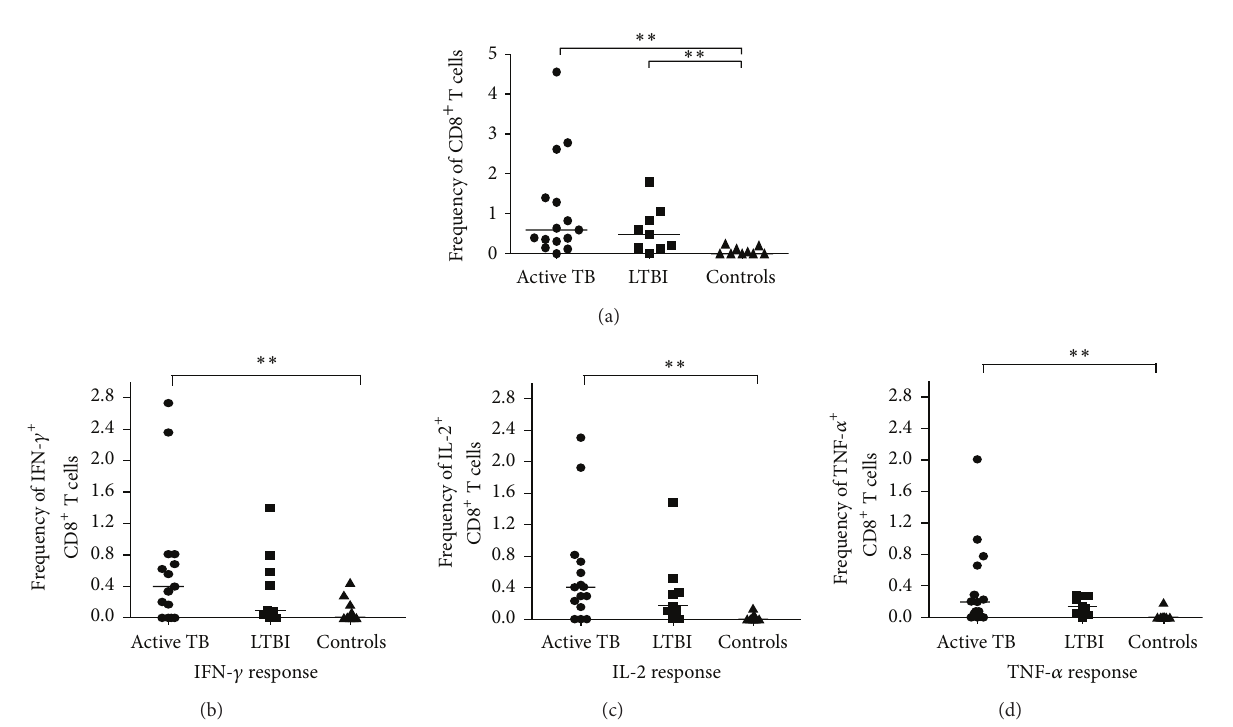
Figure 5: Analysis of cytokine production by CD8 + T cells at the single-cell level. (a) Frequencies of activated Mtb -specific CD8 + T cells producing any of the 3 cytokines (IFN- 𝛾 , IL-2, or TNF- 𝛼 ) cells in active TB patients ( 𝑛 = 18 ), in LTBI patients ( 𝑛 = 10 ), and in healthy controls ( 𝑛 = 10 ) are show. ((b), (c), and (d)) Frequency of “total IFN- 𝛾 + ,” “total IL-2 + ,” and “total TNF- 𝛼 + ” Mtb -specific CD8 + T in active TB patients ( 𝑛 = 18 ), in LTBI patients ( 𝑛 = 10 ), and in healthy controls ( 𝑛 = 10 ) is shown. Horizontal bars represent the median values. Statistical analysis was performed using Kruskal-Wallis ANOVA with Dunn’s posttest comparison and significant differences are indicated by asterisks ( ∗∗ 𝑃 < 0.01